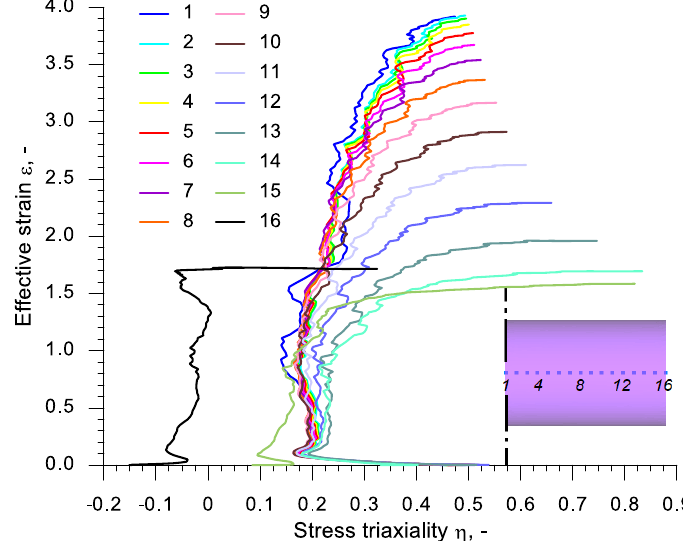
Figure 14. The dependency of effective strain on stress triaxiality in virtual sensors located in the axis of a sample with the length l 0 = 90 mm, subjected to rotational compression.